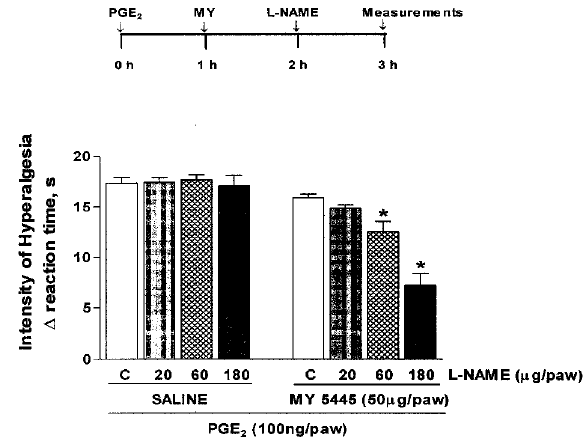
FIG. 5. Potentiation of intraplantar injections of L-NAME by the cGMP phosphodiesterase inhibitor, MY 5445. The meas- urements were made 3h after the intraplantar injections of PGE 2 (100ng/paw). MY 5445 and (or) L-NAME were injected into the paw 1 and 2h after PGE 2 , respectively. The bars are the mean ± SEM of five rats/group. The asterisk means significant differences ( P < 0.05) compared with respective doses of L-NAME. There was no significant differences between the controls groups (C) treated with saline or MY 5445.